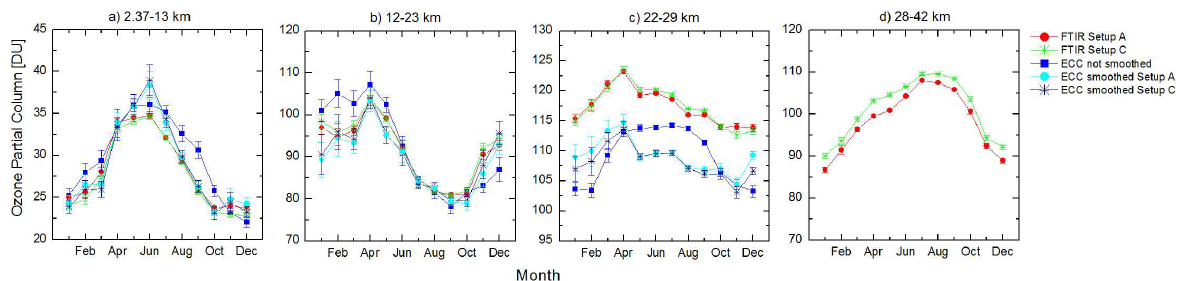
Fig. 13. Annual cycle of the ozone partial columns [DU] obtained from the FTIR (setup A and C), the corrected ECC sonde data (not smoothed and smoothed by avks from the FTIR setup A and C): (a) 2.37–13km, (b) 12–23km, (c) 22–29km and (d) 28–42km. The error bars indicate the standard error of the mean